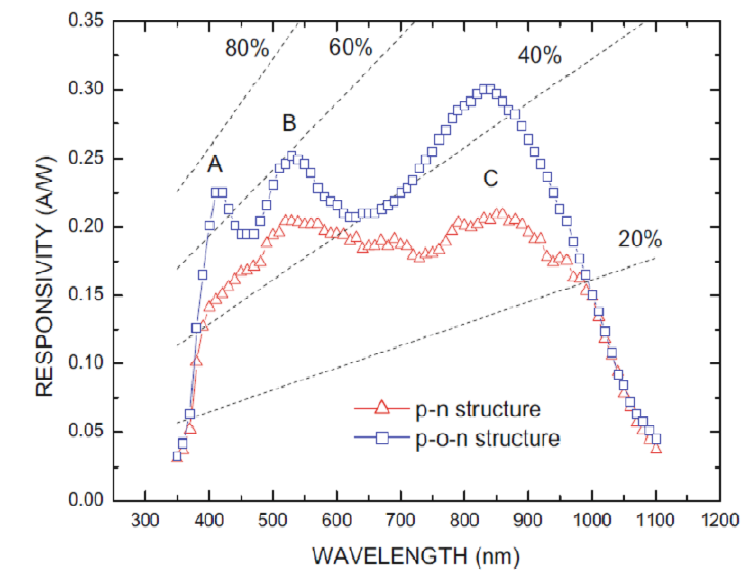
Figure 14. Responsivity as a function of wavelength for a p -ZnO/oxide/ n -Si and p -ZnO/ n - Si structure photodiodes at a bias of − 1 V